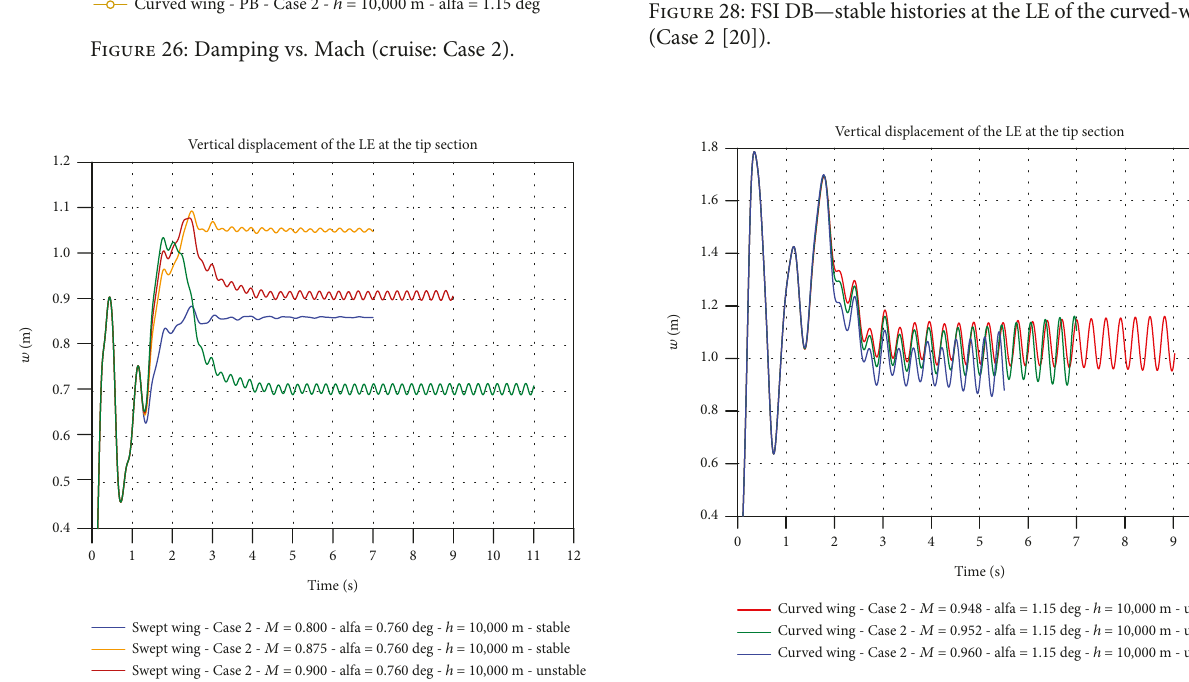
Figure 29: FSI DB — unstable histories at the LE of curved-wing tip (Case 2